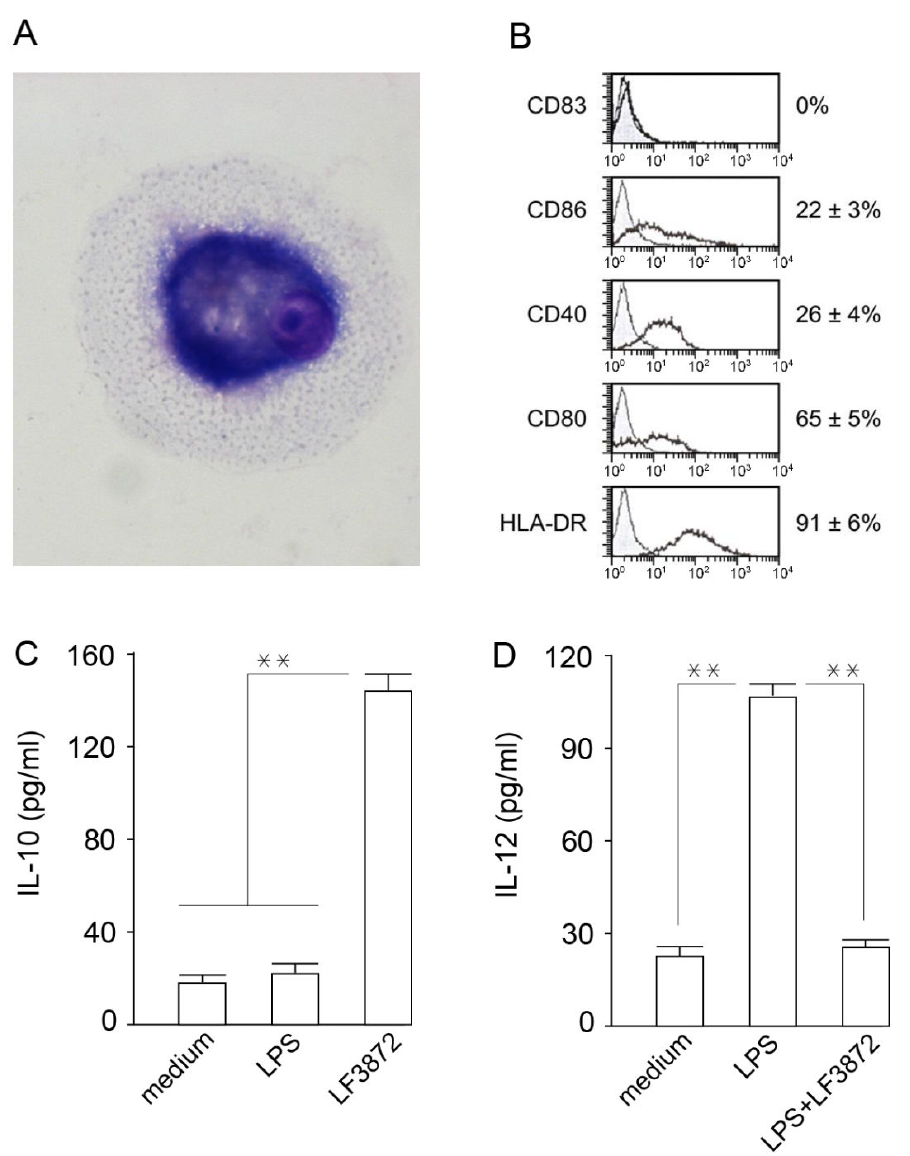
Figure 3. LF3872 regulates the production of IL-10 and IL-12 in human IDCs. ( A ) IDC—light microscopy after azure-eosin staining; ( B ) phenotype of IDCs; ( C ) LF3872 stimulates the production of IL-10; ( D ) LF3872 inhibits the production of IL-12. Notes: the amount of IDCs was 10 5 cells/mL; the ratio of IDCs/lactobacilli was 1:10; and the cultivation time was 24 h. ** p < 0.01. Figure 3C—IL-10 production in IDCs + LF3872 vs. medium, or LPS; Figure 3D—IL-12 production in IDCs + LPS vs. medium or LPS +